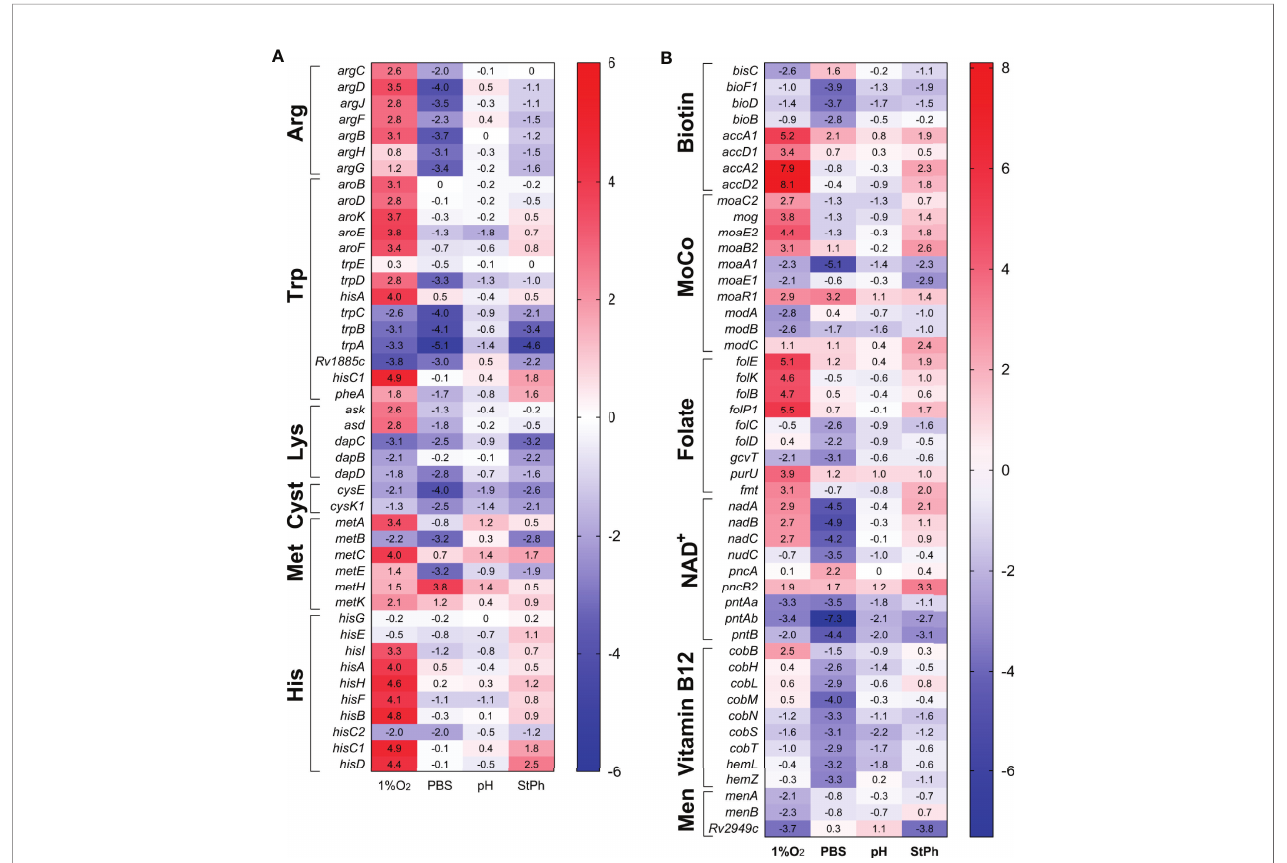
FIGURE 4 | Heat map of genes differentially expressed in (A) amino acid, (B) vitamins and cofactor biosynthesis and metabolism. The log2 fold change for each gene and condition is indicated in the